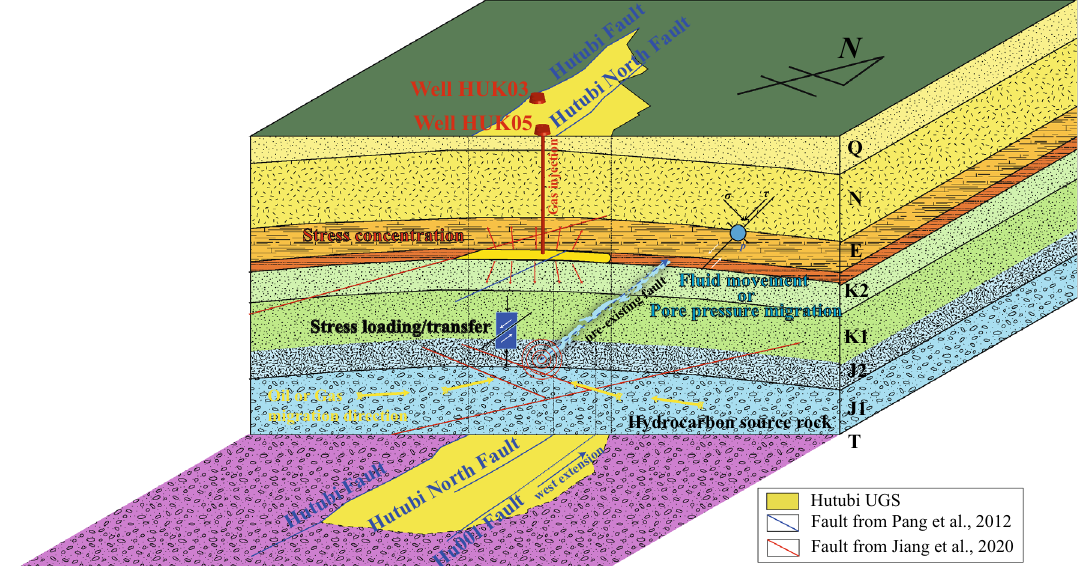
Figure 8. Schematic illustration of the hypocenter migration during the second injection period. The rocks in the hydrocarbon source formation are likely porous and may be partially saturated with fluids. Disturbed by the UGS loadings, microcracks begin to cohere along the preexisting fault, leading to fault sliding (earthquake). This sliding promotes increased pore-fluid migration along the existing fault, driving the earthquake migration to a shallower